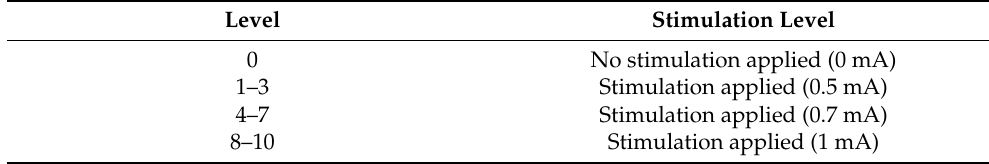
Table 1. The electrical energy of each